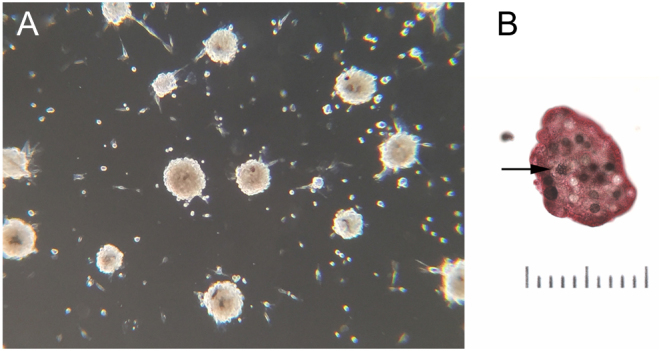
Cell cultures of RS0 cells grown in serum free medium. (A) Darkfield photomicrograph showing typical appearance of tumor cell spheroids, which often form on top of cells attached to the culture dish, then detach and grow suspended in the medium. (B) Cytocentrifuge preparation showing a representative microsphere immunohistochemically stained for tyrosine hydroxylase (red cytoplasm) and bromodeoxyuridine (BrdU, black nuclei) after 7 days of BrdU labeling. White circles within the microsphere are unlabeled nuclei. Arrow indicates a labeled mitotic figure, indicating that incorporating BrdU can go on to divide. Bar = 100 µm.